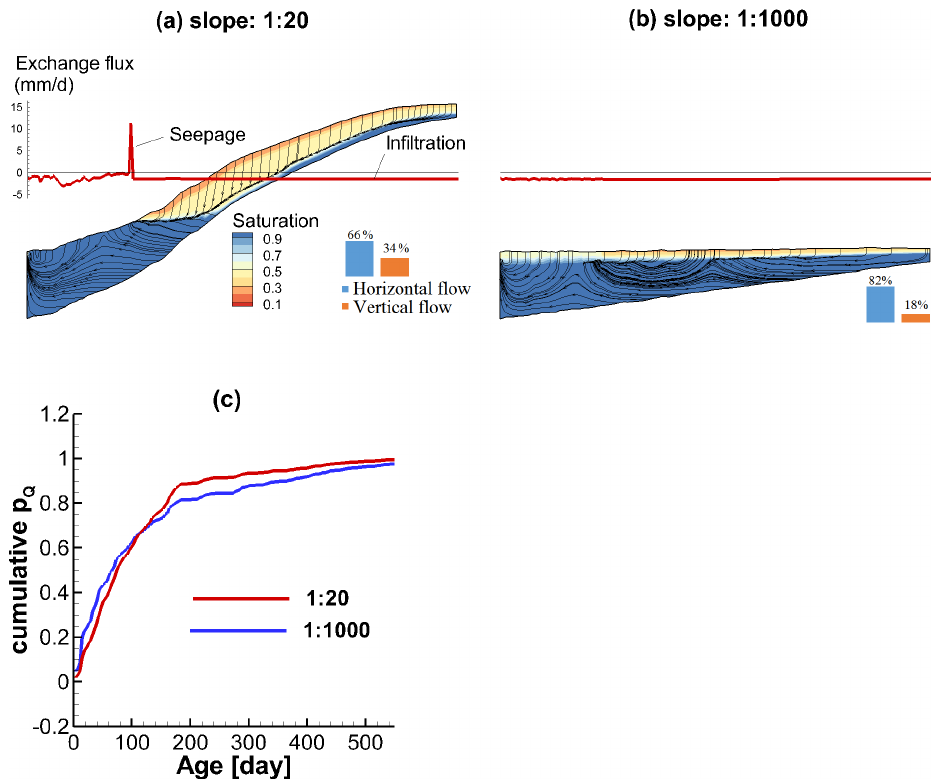
Figure 7. Cross-sectional view of saturation, flow paths, and exchange fluxes between the surface and the subsurface in the wet season (February) for catchments with topographic slope (a) 1 : 20, and (b) 1 : 1000. The cross section is marked in Fig. 1a. The black lines represent the flow paths. The red curves show exchange fluxes (along the cross-sectional profiles), positive values indicate seepage to the land surface and negative values indicate infiltration to the subsurface. (c) The computed cumulative TTDs for Q during the wet season (February), for the catchment with topographic slope of 1 : 20 and 1 :